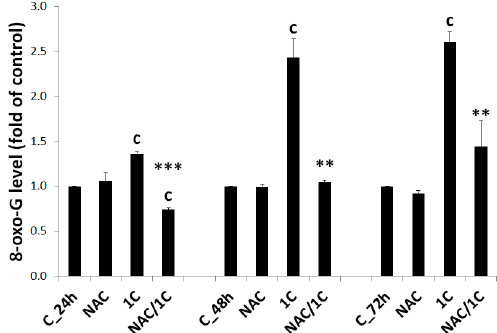
Figure 3. Oxidative DNA damage detection using 8-oxo-7,8-dihydroguanine (8-oxoG) level measurement after 24, 48, and 72 h incubation of HCT116 cells with 1C and NAC/1C. Significantly different c p < 0.001 vs. untreated cells (control); ** p < 0.01, *** p < 0.001 vs. 1C.